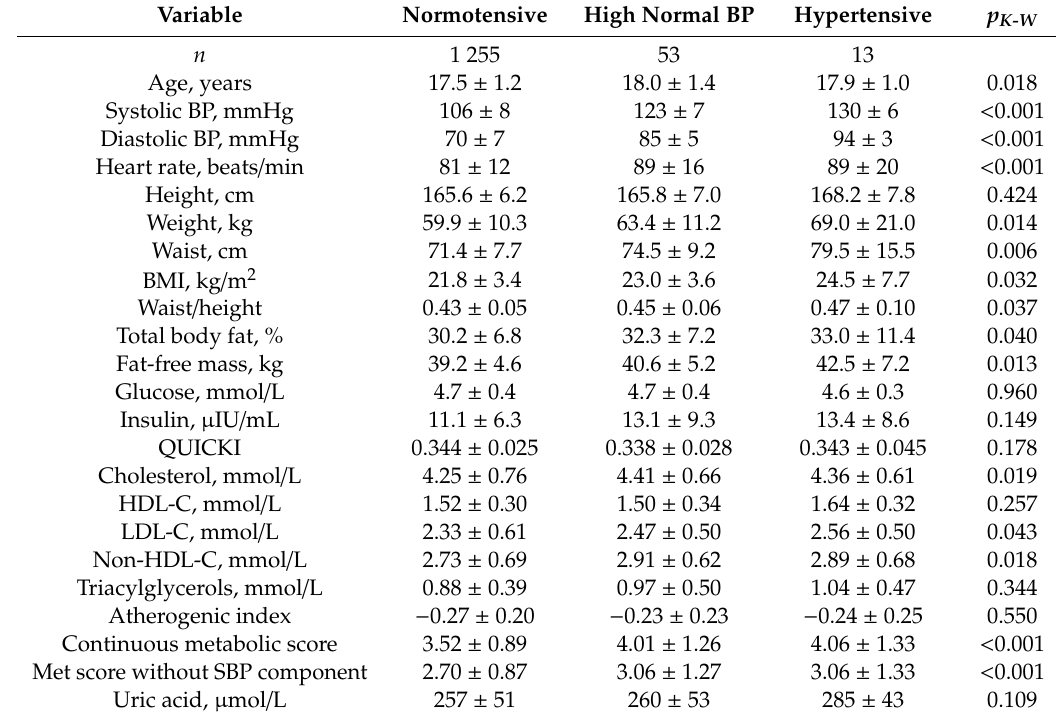
Table 6. Characteristics of